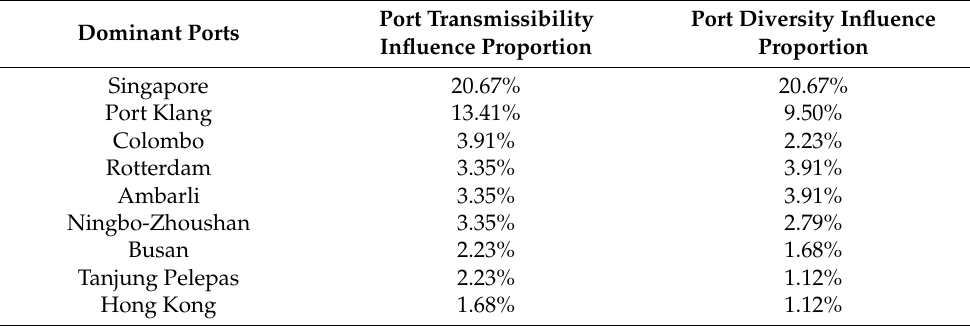
Table 2. The influence proportion of dominant ports on other ports’ resilience. Dominant